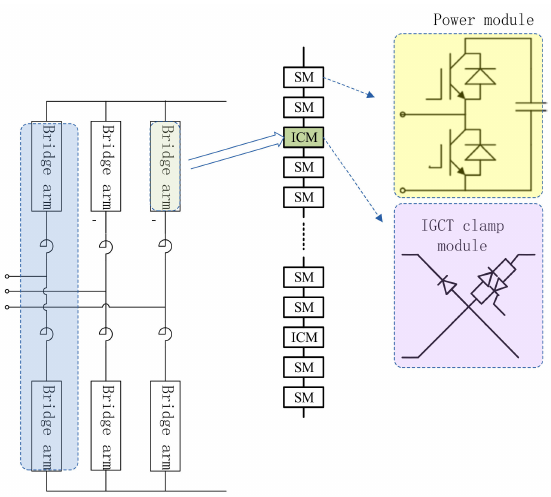
Figure 3. Topology of MMC based on Integrated Gate Commutated Thyristors (IGCT)